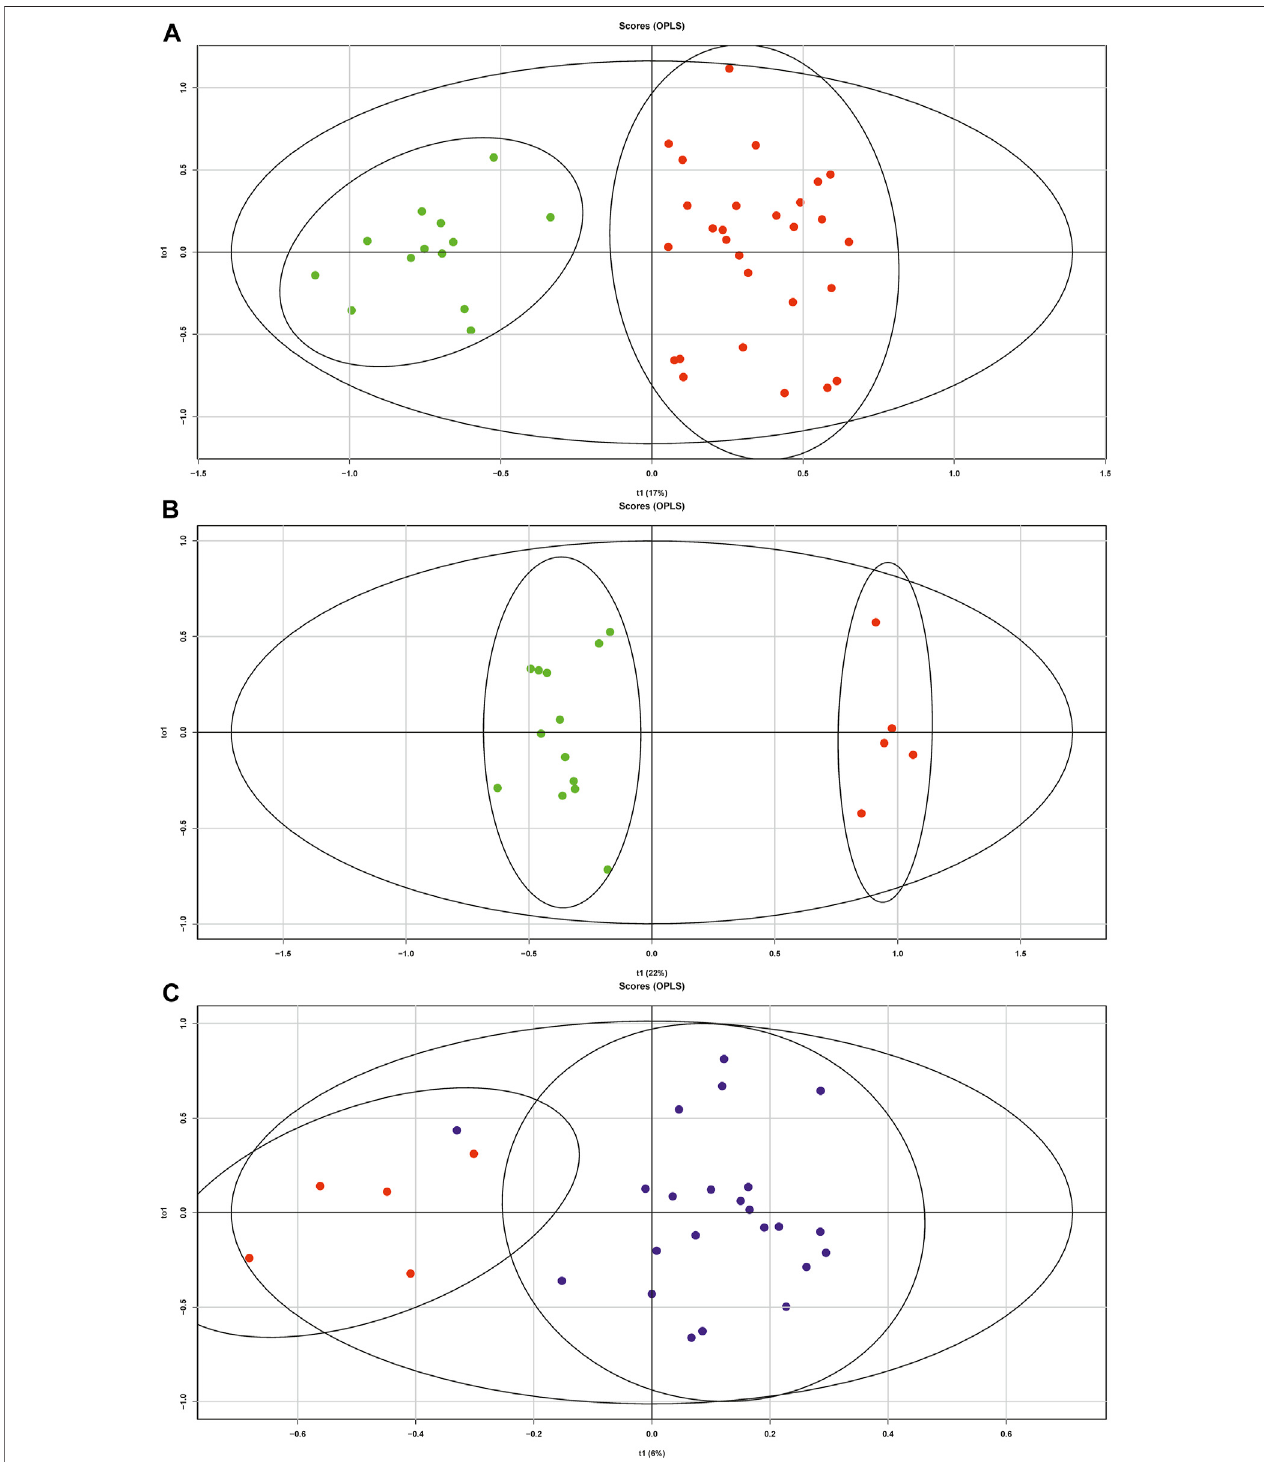
FIGURE 2 | (A) Score plots based on the results of OPLS-DA analysis of MS data obtained in the positive ion mode for the blood plasma lipid extracts: (A) control group (green dots) and OC of stages I-IV (red dots); (B) control group (green dots) and OC of stages I-II (red dots); (C) OC of stages I-II (red dots) and stages III-IV (blue